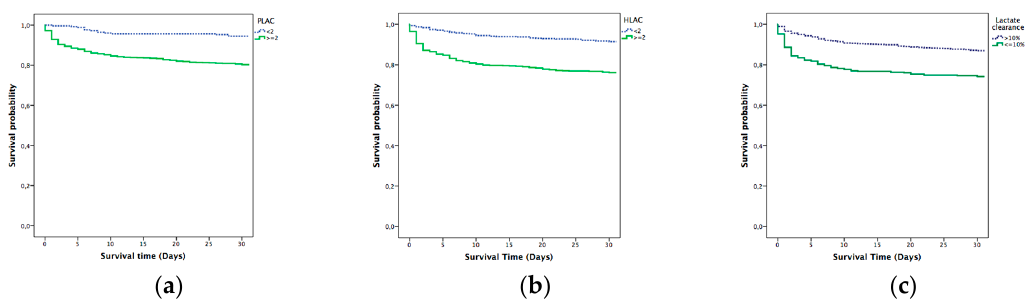
Figure 5. Kaplan–Meier analysis for 30 day mortality: ( a ) prehospital lactate; ( b ) hospital lactate; and ( c ) lactate clearance. PLAC: prehospital lactate; HLAC: hospital lactate.